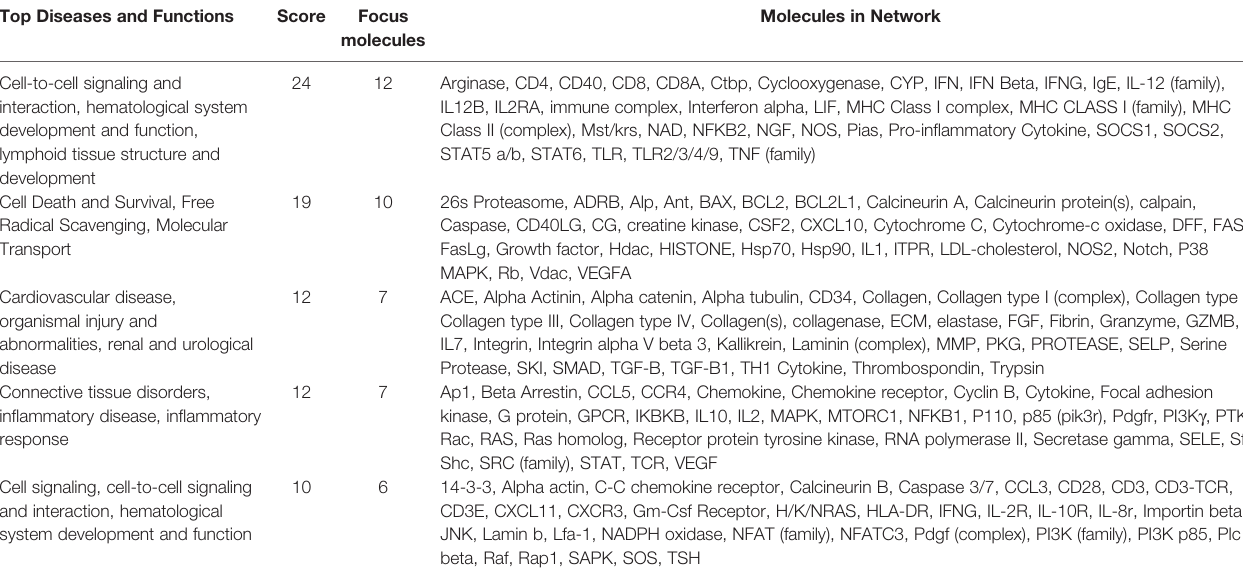
TABLE 1 | Top disease and functions gene networks on regulated immune genes for the chronically infected group identi fi ed by the IPA software. Top Diseases and Functions Score Focus